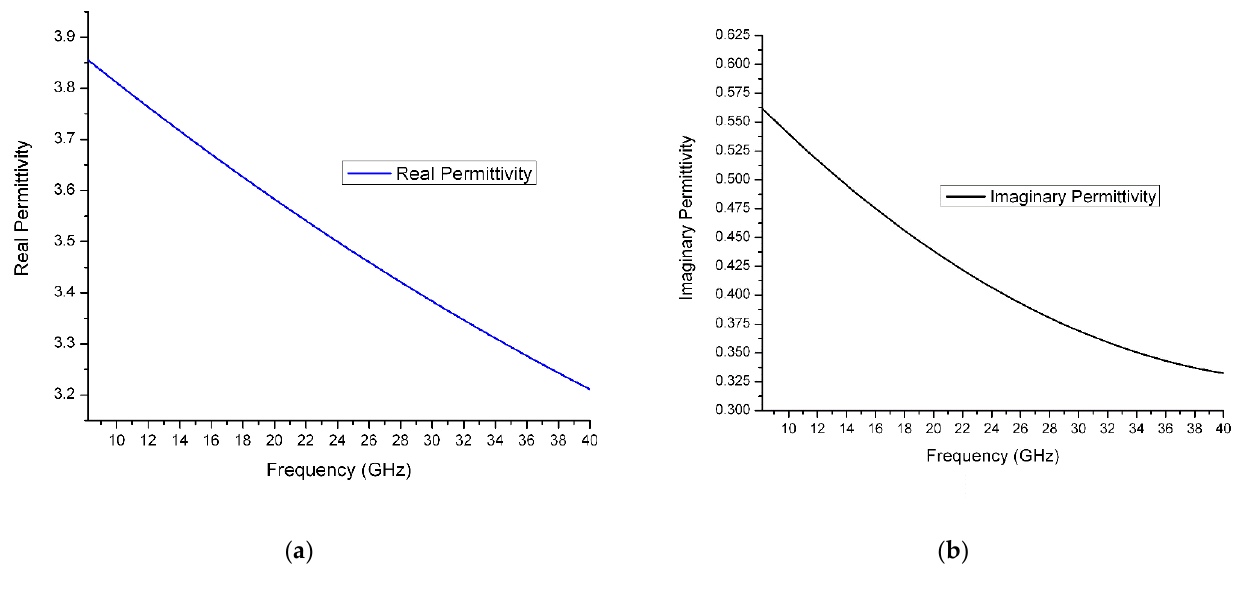
Figure 9. ( a ) Real part of relative permittivity of solid polymer electrolyte from 8.2 GHz to 40 GHz. ( b ) Imaginary part of relative permittivity of solid polymer electrolyte from 8.2 GHz to 40 GHz.